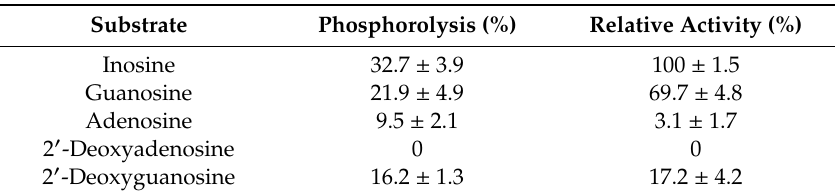
Table 1. Substrate specificity of Am PNP.